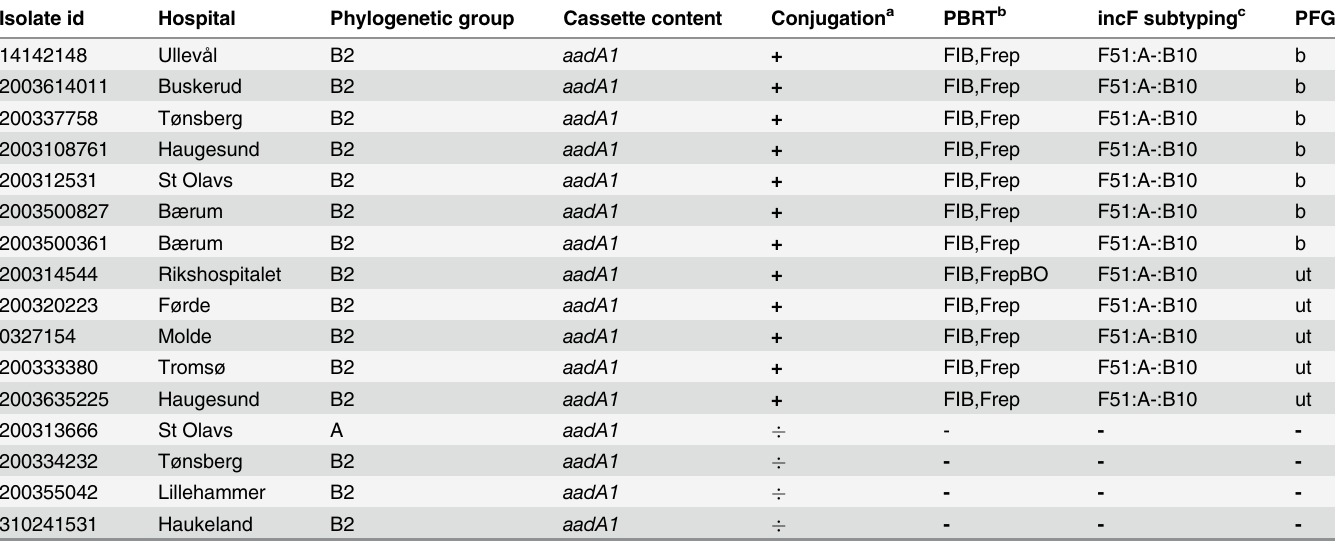
The isolates were recovered from humans with blood stream infections. a